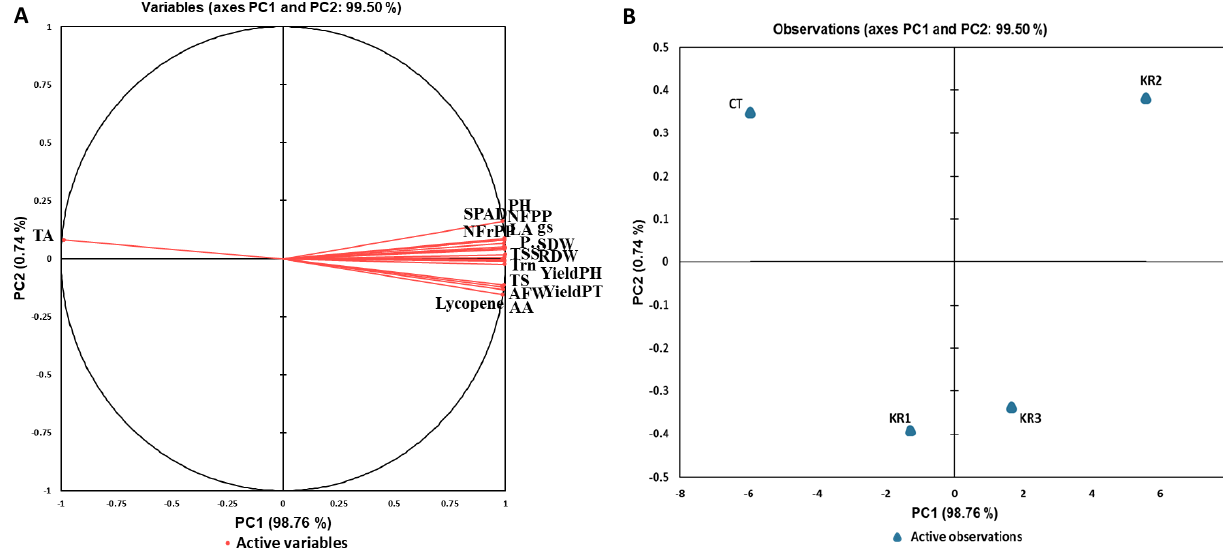
Figure 6. Principal component analysis of tomato plants treated with biostimulants: ( A ) Loading plot of variables; ( B ) scoring plot of treatments. Treatments include CT, control; KR1, Kendal Root 2.5 L ha − 1 ; KR2, Kendal Root 5.0 L ha − 1 ; KR3, Kendal Root 10.0 L ha − 1 . The variables are plant height (PH), leaf area (LA), shoot dry weight (SDW), root dry weight (RDW), SPAD value, photosynthetic rate (Pn), stomatal conductance (gs), transpiration rate (Trn), number of fruits per plant (NFrPP), yield per plant (YieldPP), yield per hectare (YieldPH), total soluble solids (TSS), ascorbic acid content (AA), lycopene, total sugars (TS), and titratable acidity (TA).